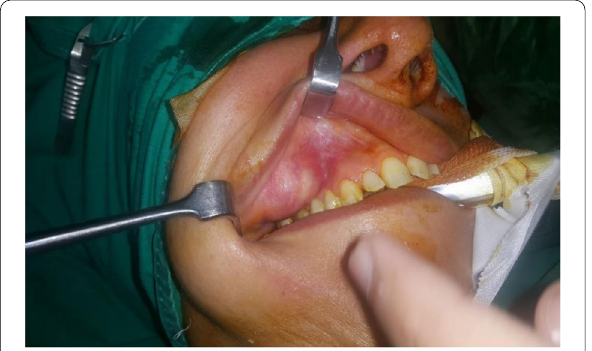
Fig. 2 Preoperative view showing a mass in the right cheek